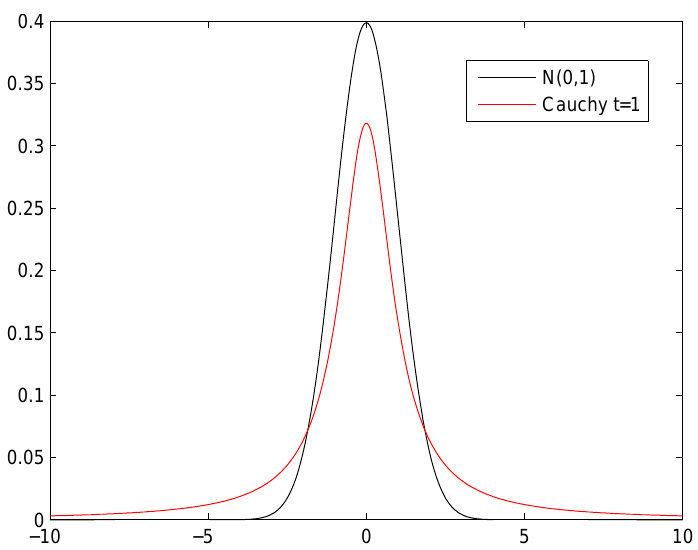
Figure 2. Illustration of the Cauchy mutation versus Gaussian